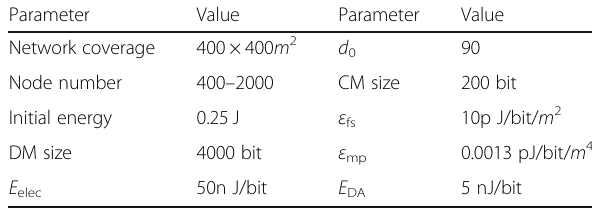
Table 1 Network environment simulation